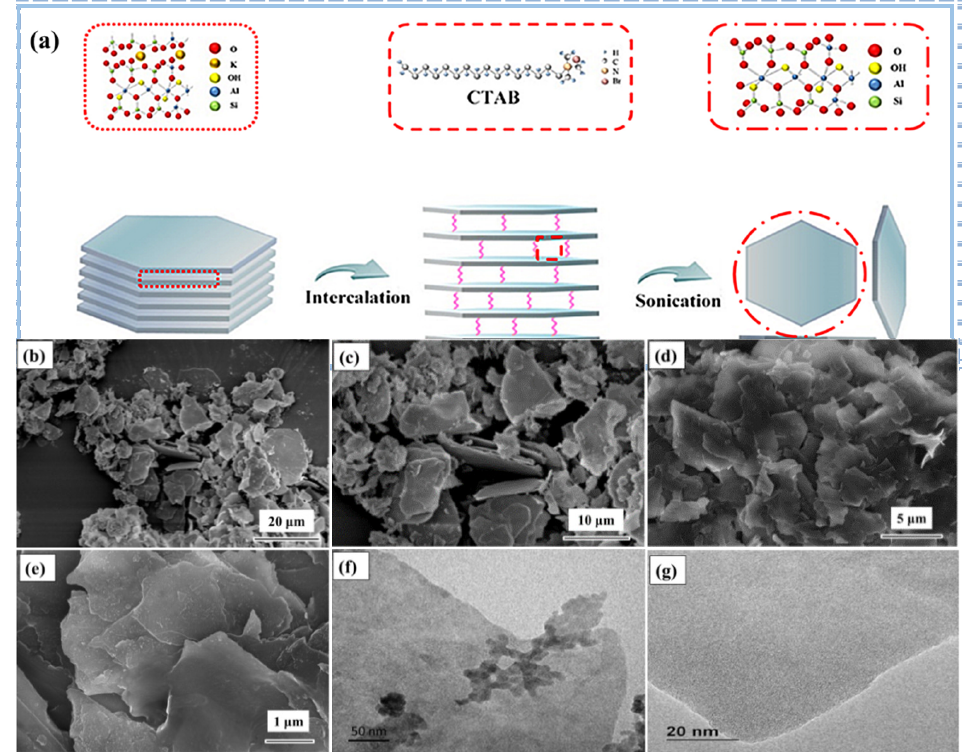
Figure 1. ( a ) Schematic illustration of 2D nano-mica sheet prepared by intercalation stripping method; ( b – e ) SEM images of nature mica powder and 2D nano-mica sheet; ( f , g ) TEM images of 2D nano-mica sheet.